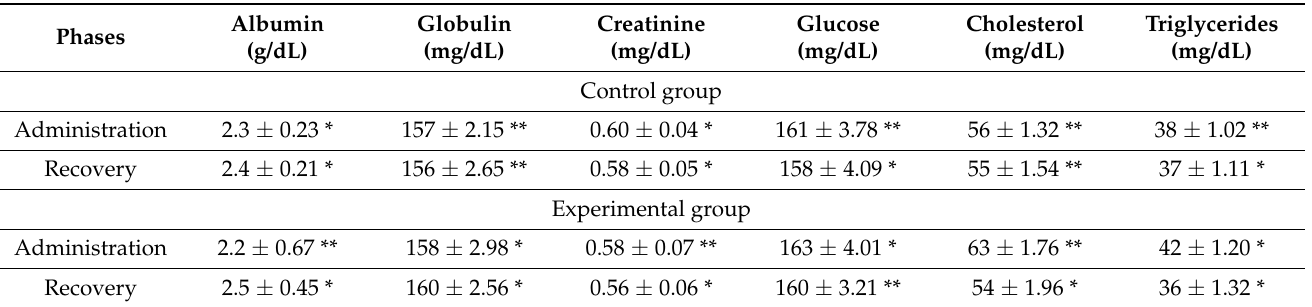
Table 4. Biochemical parameters (n =